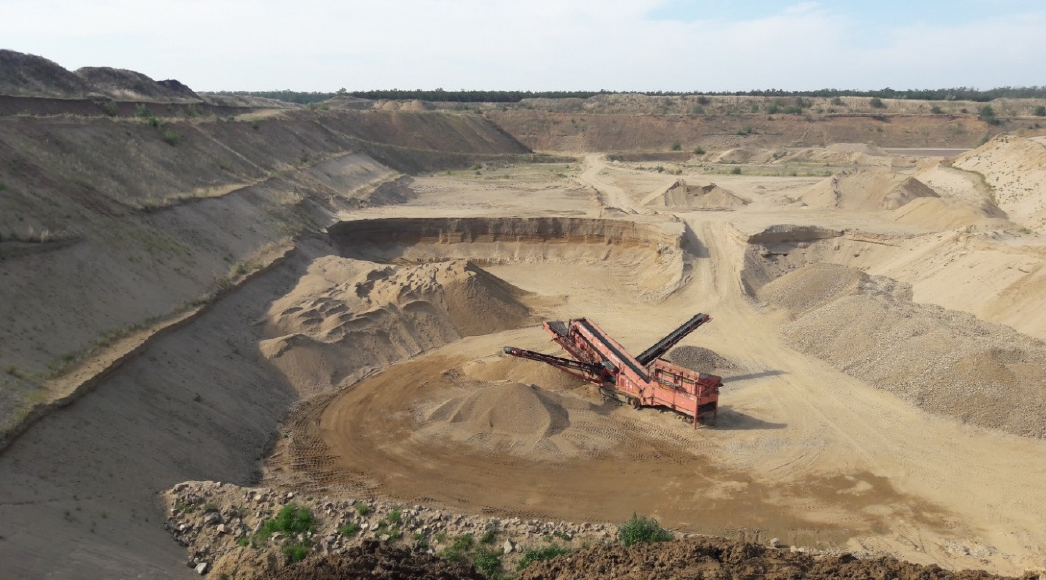
Figure 8. Sand and gravel pit Ledce-Hrušovany u Brna. Photo: Courtesy LB MINERALS, s.r.o., 2018.